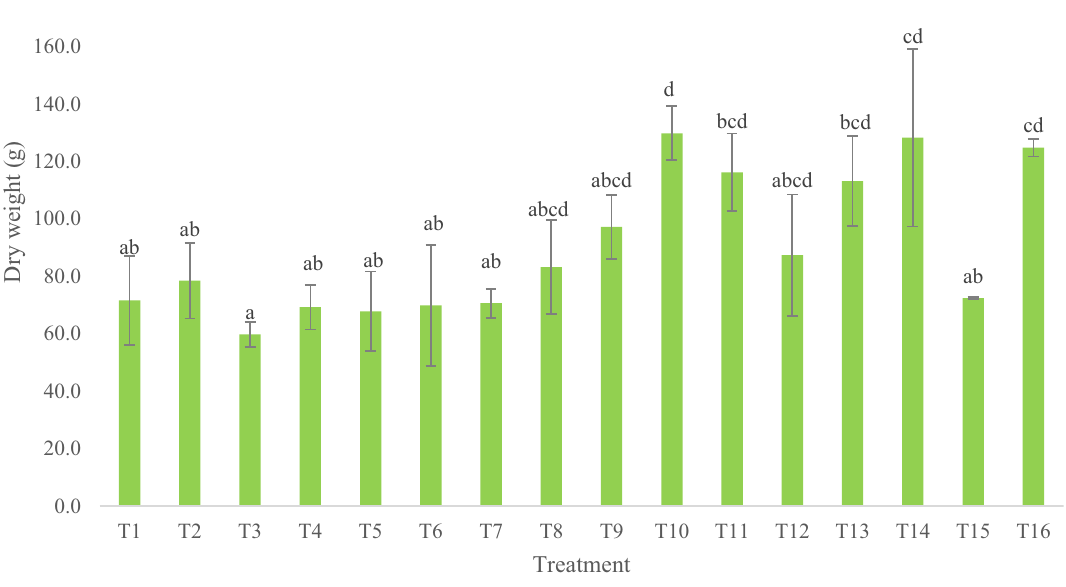
Fig. 2 Effect of fertilizer treatments on dry weight of patchouli. Error bars indicate standard error of two replications and three plants per repli- cate. Different letters show significant differences according to Duncan’s test (P =